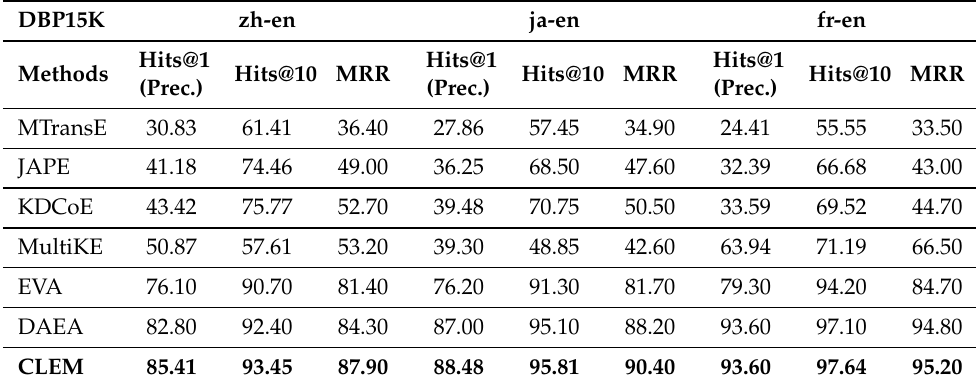
Figure 3. The result of the multi-view integration experiment in terms of Hits@1. Table 3. The comparison results between CLEM and other entity matching methods.